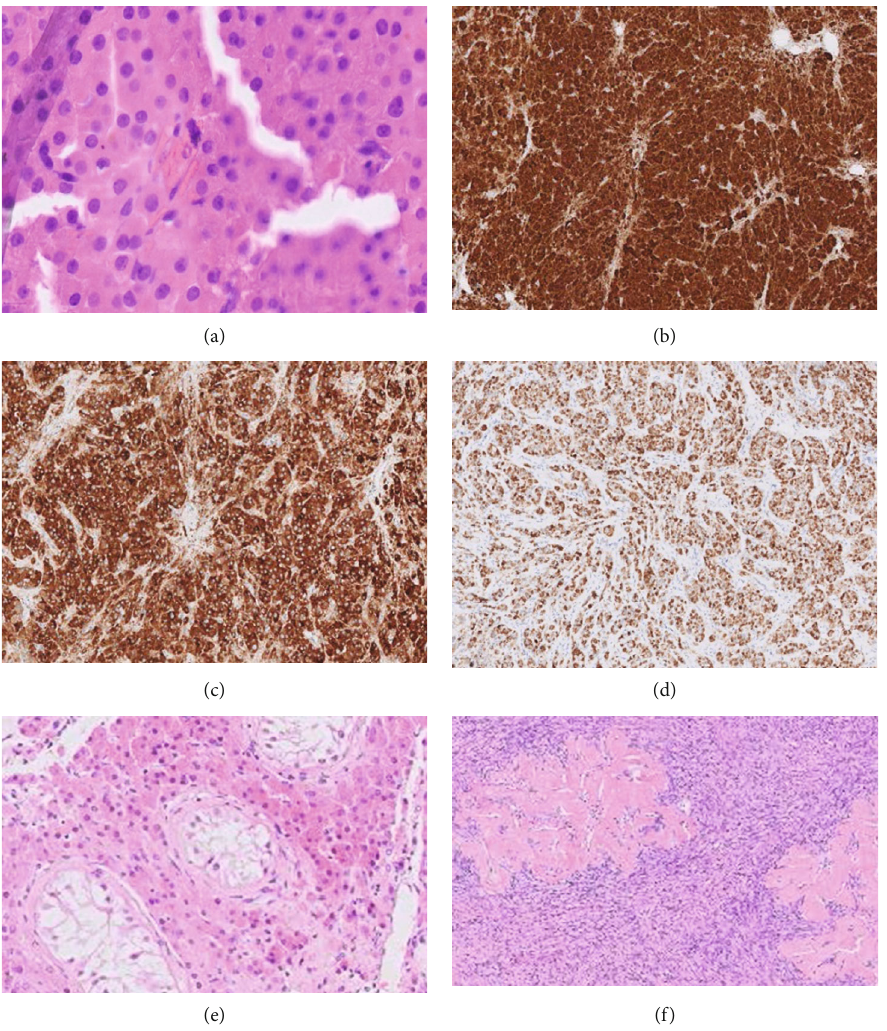
Figure 2: Leydig cell tumor with characteristic Reinke crystalloids (a), positivity for calretinin (b), inhibin (c), and melanA (d). Compressed seminiferous tubules in the Leydig cell tumor (e). Ovarian tissue with corpora albicantia